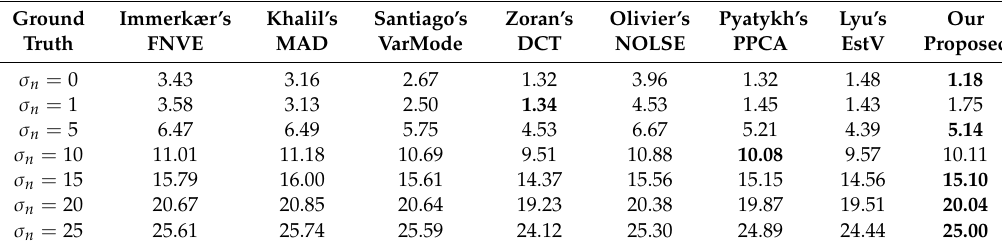
Table 2. The results of di ff erent AWGN estimation algorithms on the Kodak PCD0992 images. Ground Truth